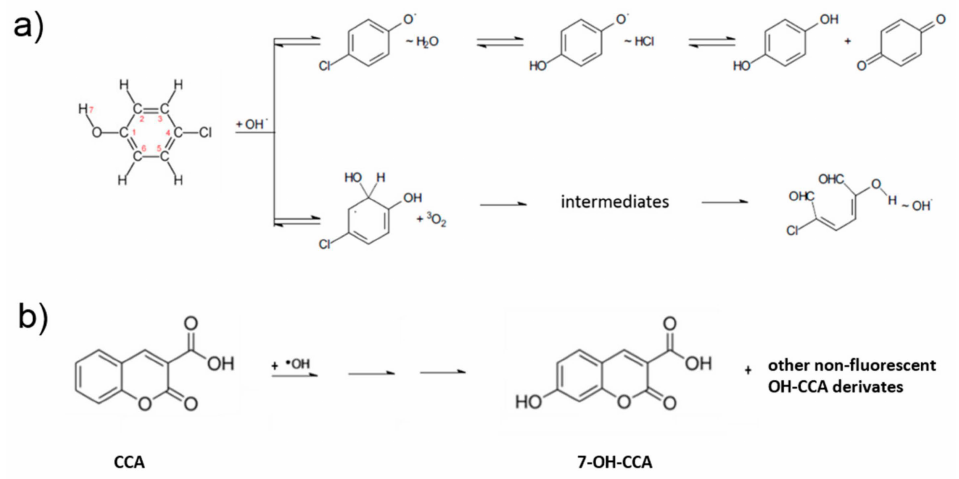
Figure 4. ( a ) Simplified scheme of the photocatalytic 4-chlorophenol degradation. ( b ) Reaction of OH radical with coumarin 3-carboxy acid to form fluorescent molecule 7-hydroxy coumarin 3-carboxy